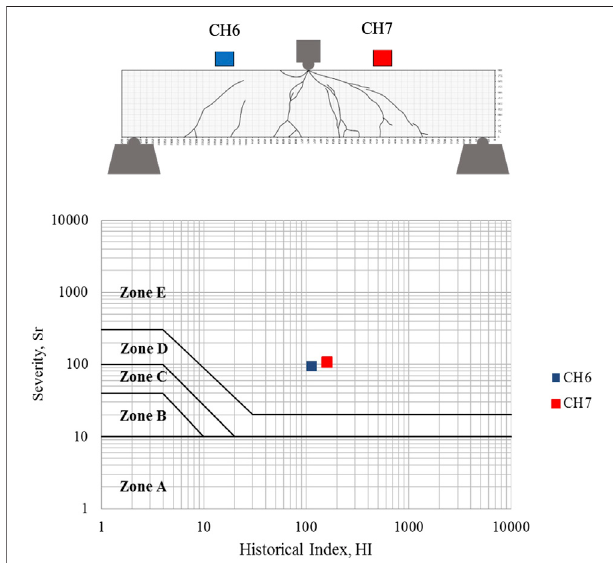
FIGURE 11 | The crack zones obtained from CH6 and CH7 for beam S1C under CM6.